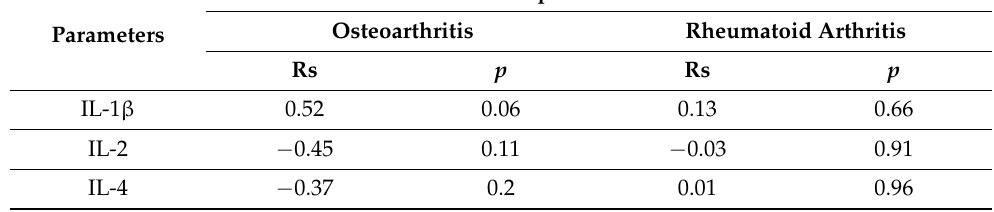
Table 2. Correlations between adiponectin plasma levels and selected cytokines (IL-1 β , IL-2, IL-4, RA patients. Rs—Spearman rank correlation coefficient; G-CSF—granulocyte colony-stimulating factor; GM-CSF—granulocyte-macrophage colony-stimulating factor; IFN- γ